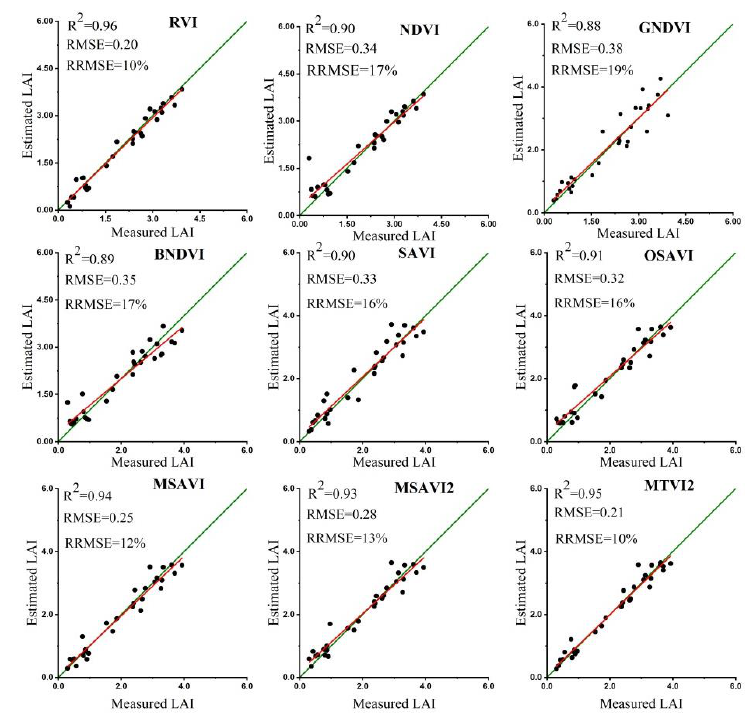
Figure 4. Estimated vs. measured LAI at the elongation stage. The green line shows the 1:1 correlation of the estimated and measured variables, whereas the red lines present the linear regression models. Remote Sens. 2020 , 11 , x FOR PEER REVIEW